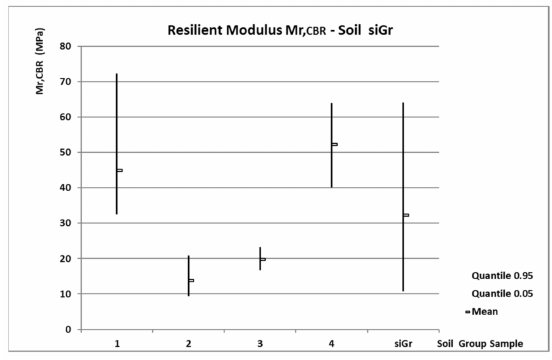
Figure 9. Statistical quantities—mean, 0.05 quantile, 0.95 quantile of M r,CBR for siGr soil.